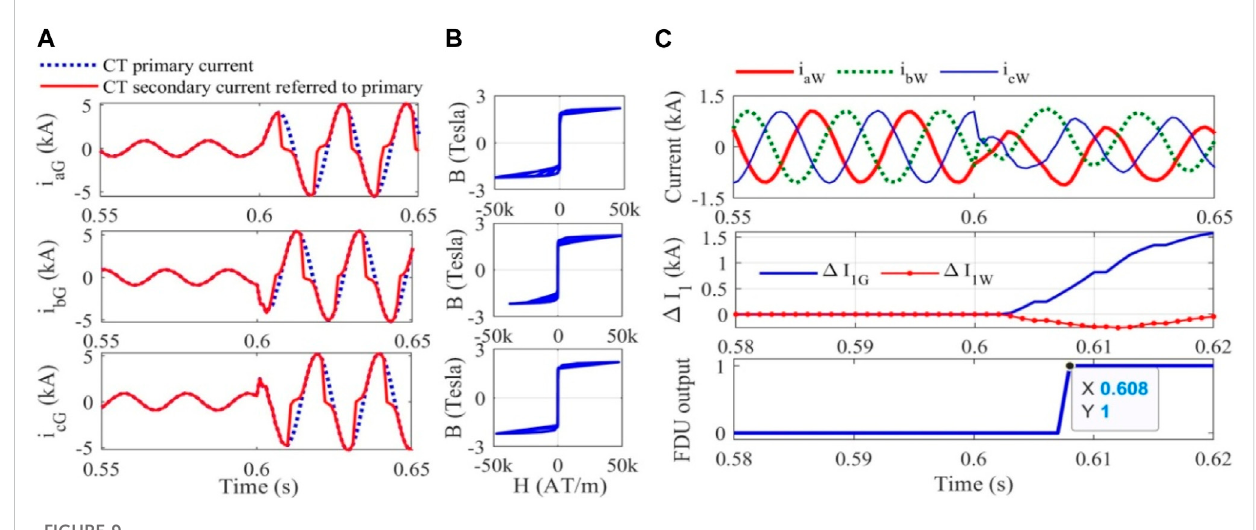
FIGURE 9 Performance of the proposed fault detection algorithm for faults producing CT